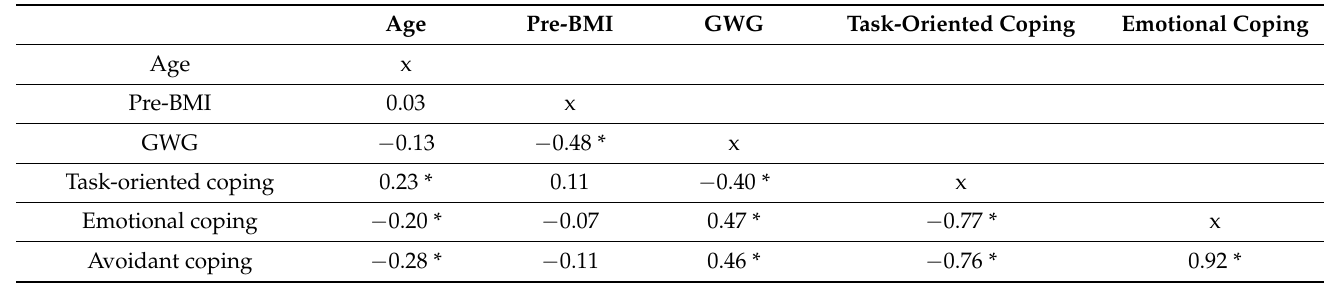
Table 3. Spearman’s rank correlation matrix for the whole group ( n = 102).